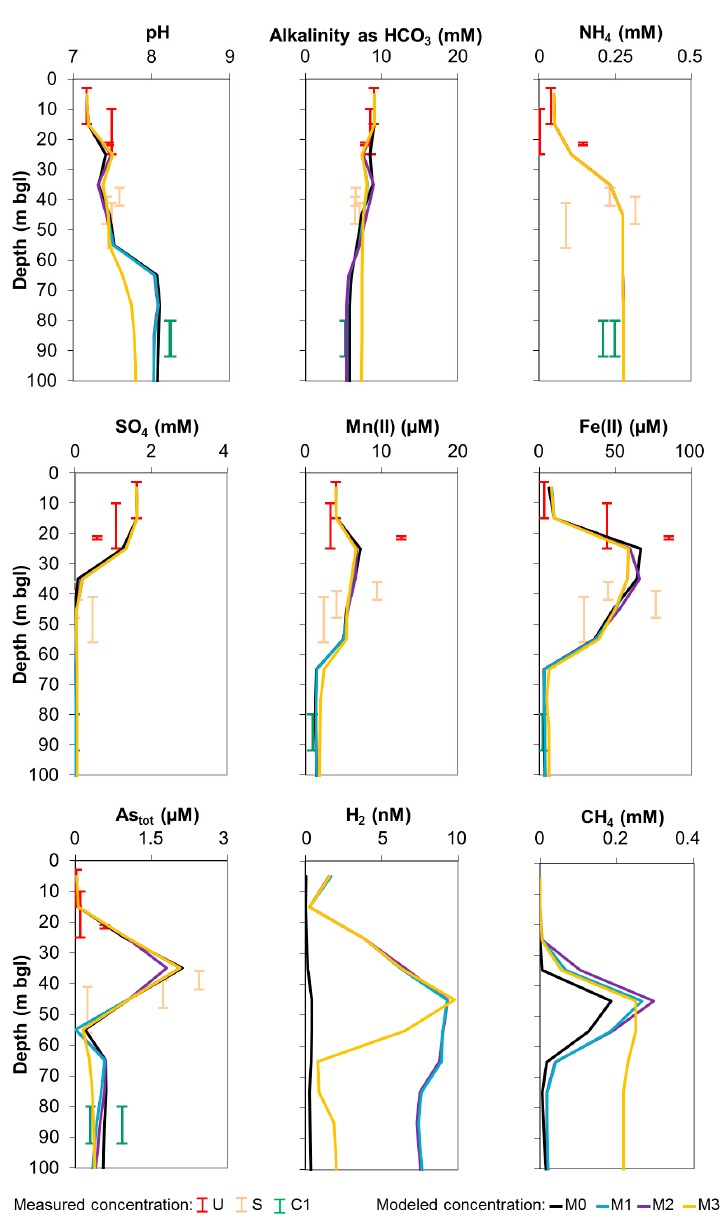
Figure 1. Measured vs. modeled molar concentrations of selected species over depth; symbol length corresponds to well screen interval; U, S, and C1 refer to unconfined, semi-confined, and confined 1 aquifer units, respectively; M0, M1, M2, and M3 refer to the four implemented models. The optimal threshold energies fitted for Model 1 were 3.76, 4.50, and 1.60 kJ/mol e − for Fe-oxide